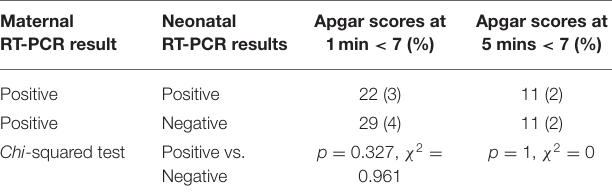
TABLE 2 | Number of apgar scores under 7 at 1 and 5 mins according to neonatal RT-PCR